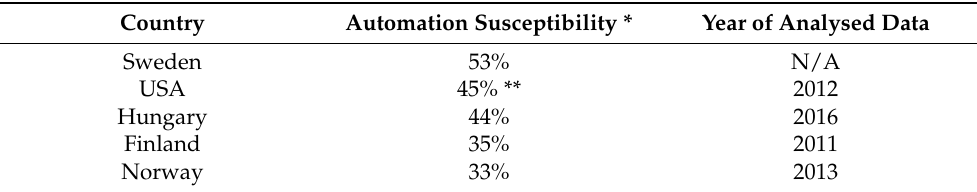
Table 1. The aggregated indicators of susceptibility to automation in the examined